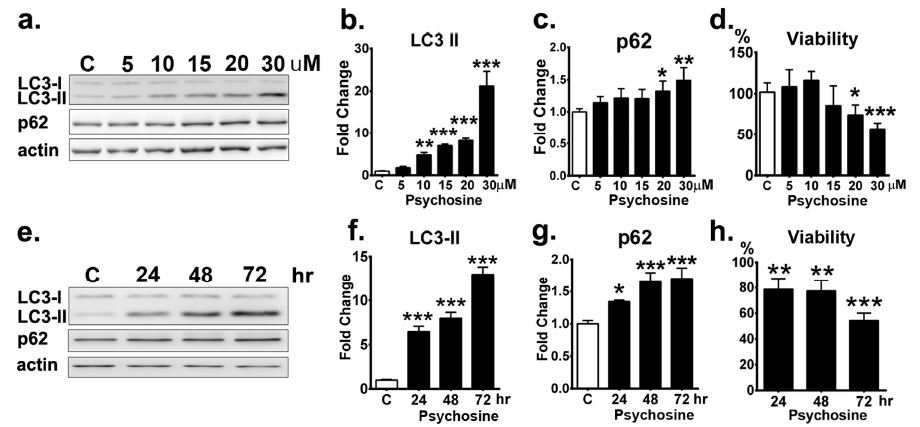
Figure 7. Dose- and time-dependent cytotoxicity of psychosine upon MO3.13 cells. ( a ) Western blot analysis of total LC3-II and p62 in MO313 cells treated with different concentration of psychosine (psy) for 24 h. β -actin (actin) was used for the loading control. ( b , c , d) Quantification of total LC3-II ( b ) and p62 ( c ) and cell viability ( d ). e Western blot analysis of total LC3-II and p62 in MO313 cells treated with 20 µM psychosine for 72 h. ( f , g , h) Quantification of total LC3-II (f) and p62 ( g ) and cell viability ( h ). Values are expressed as mean ± S.D. (Western blot, n = 3; Viability, n = 6). Statistical significance * p < 0.05, ** p < 0.01, *** p < 0.001. MO313 cells without treatment are labeled as a control group (C).